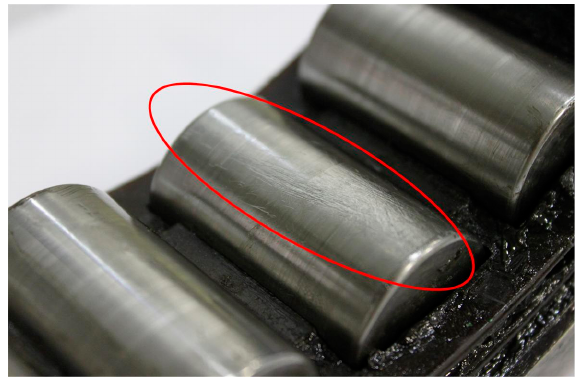
Figure 11. The rolling element fault bearing.